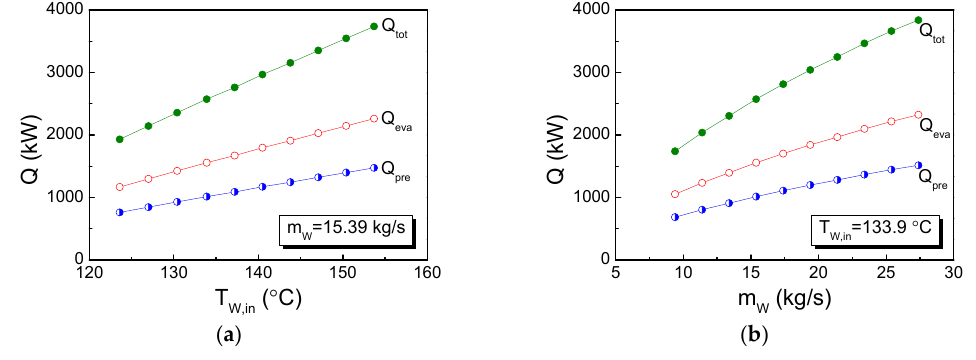
Figure 4. Heat transfer rate as functions of ( a ) T W,in and ( b ) m W .